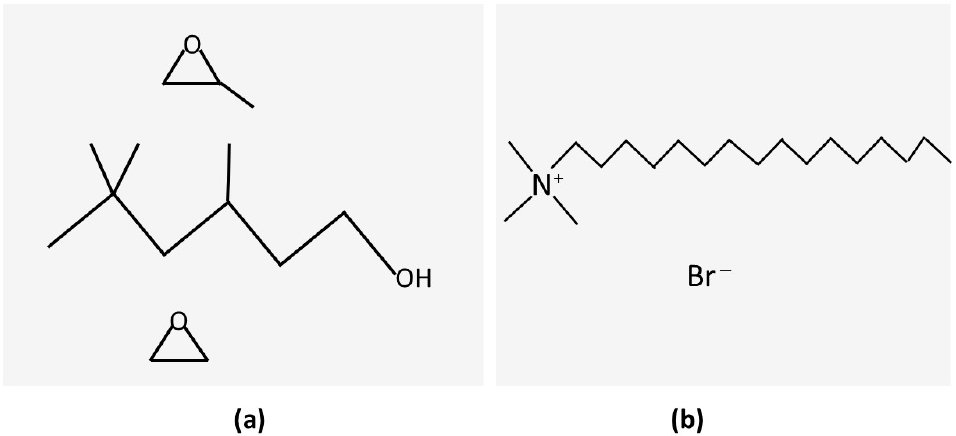
Figure 2. Chemical structures of the surfactants used in this study. ( a ) Oxirane, methyl-, polymer